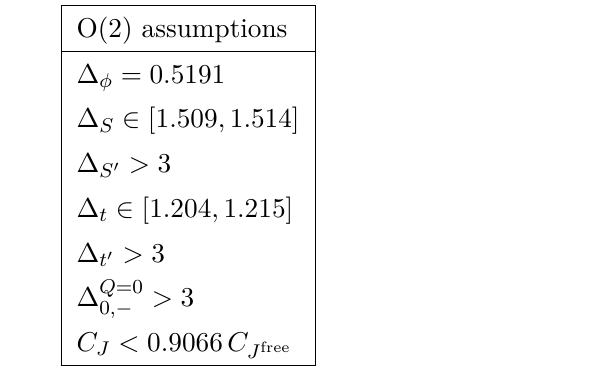
Table 1 . List of assumptions used in our analysis. The bound for ∆ S is taken from [10]. The bound for ∆ t and C J are taken from [8]. S 0 and t 0 are respectively the first operators appearing after S and t . Evidences for the gap on ∆ Q =0 were presented in 0 , −